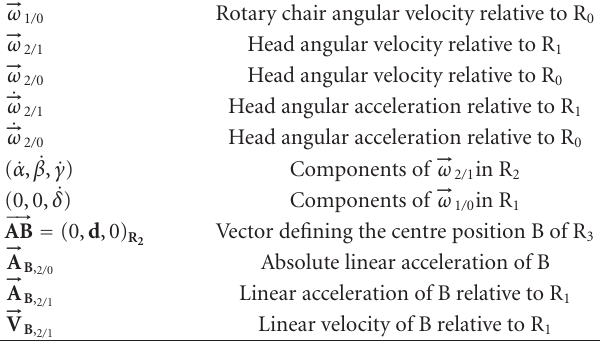
Table 4: Model kinematic